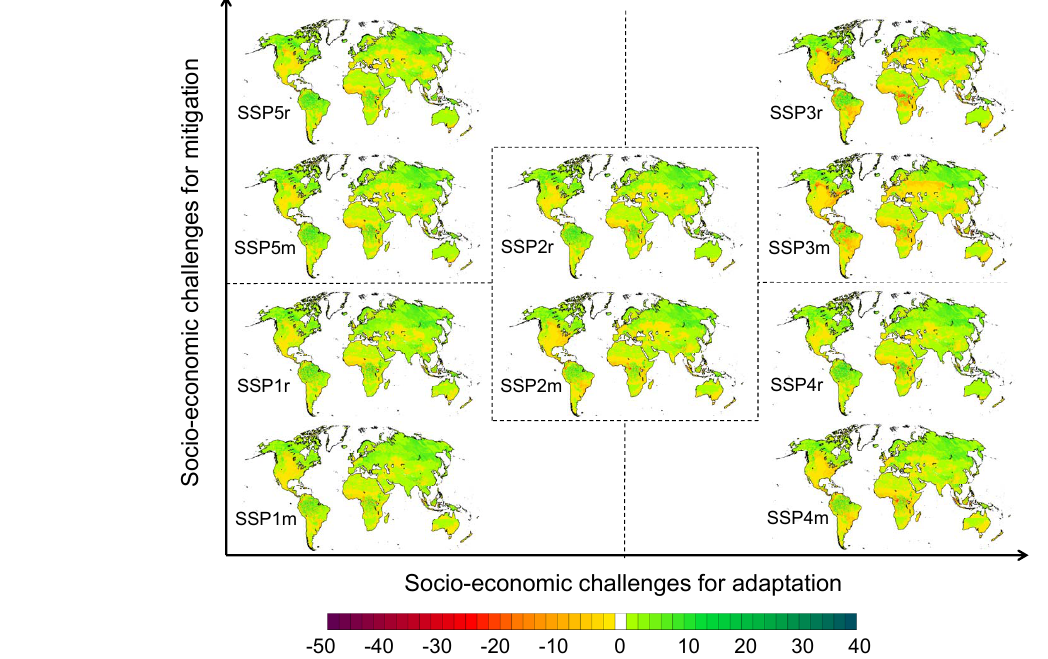
Figure 8. Changes in modelled total terrestrial carbon pool (kgm − 2 ) for 2000–2100. Green to blue colours indicate an increase in the carbon pool, while yellow and purple colours indicate a decrease in carbon pool.